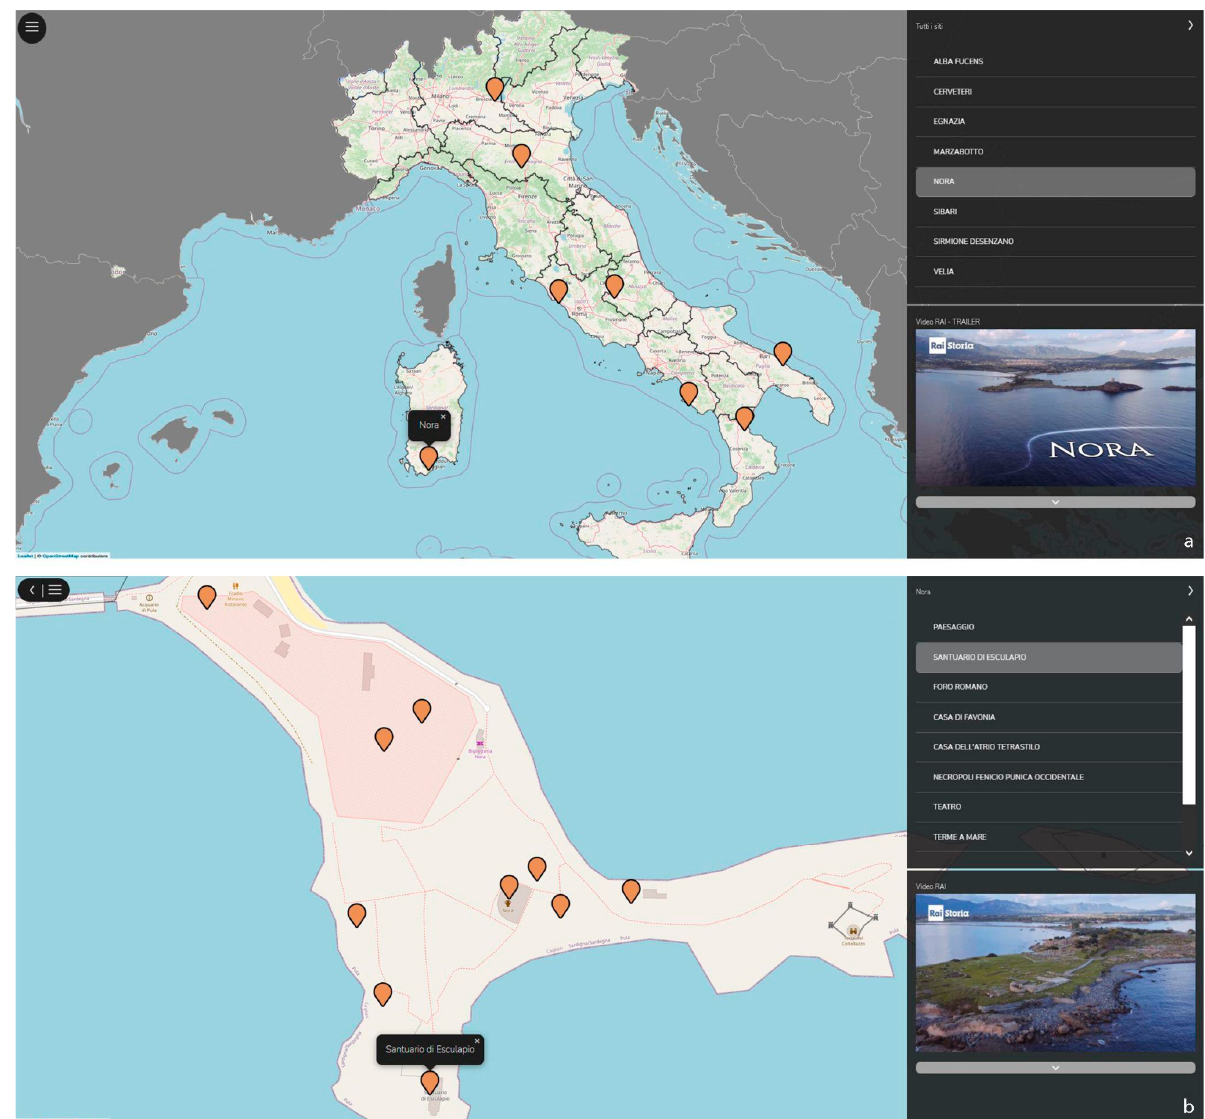
Figure 10. e-Archeo 3D: ( a ) interface with the initial choice of site; ( b ) points of interest at the archaeological site of Nora (by 3D Research).